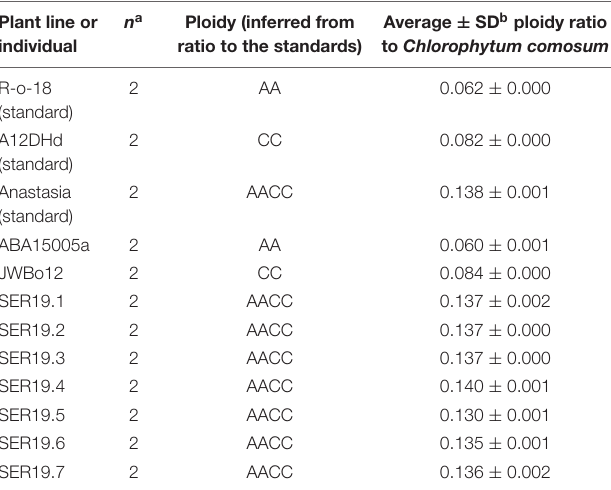
TABLE 3 | Ploidy of SER19.1–7 S 1 individuals from population SER19001 derived from the interspecific cross of TuYV-resistant lines ABA15005a ( B. rapa ) and JWBo12 ( B. oleracea